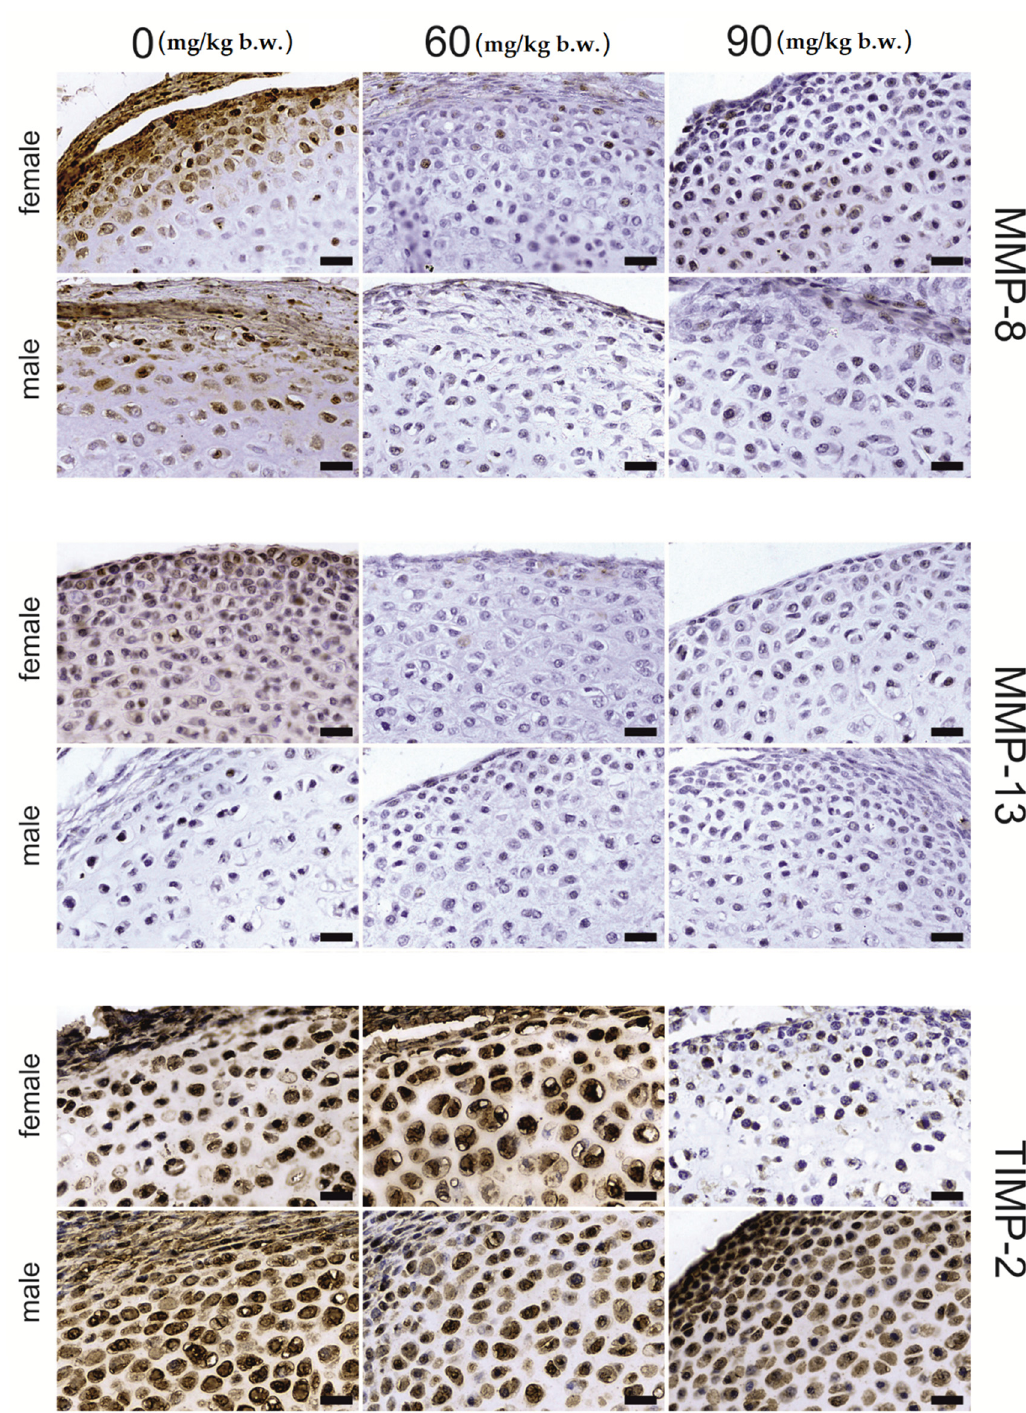
Figure 4. Representative images of the immunohistochemical reactions for MMP-8, MMP-13 and TIMP-2 from the articular cartilage of newborn rats (female and male) exposed prenatally to 0, 60 and 90 mg/kg b.w. of fumonisins. All the scale bars represent 40 μ m.